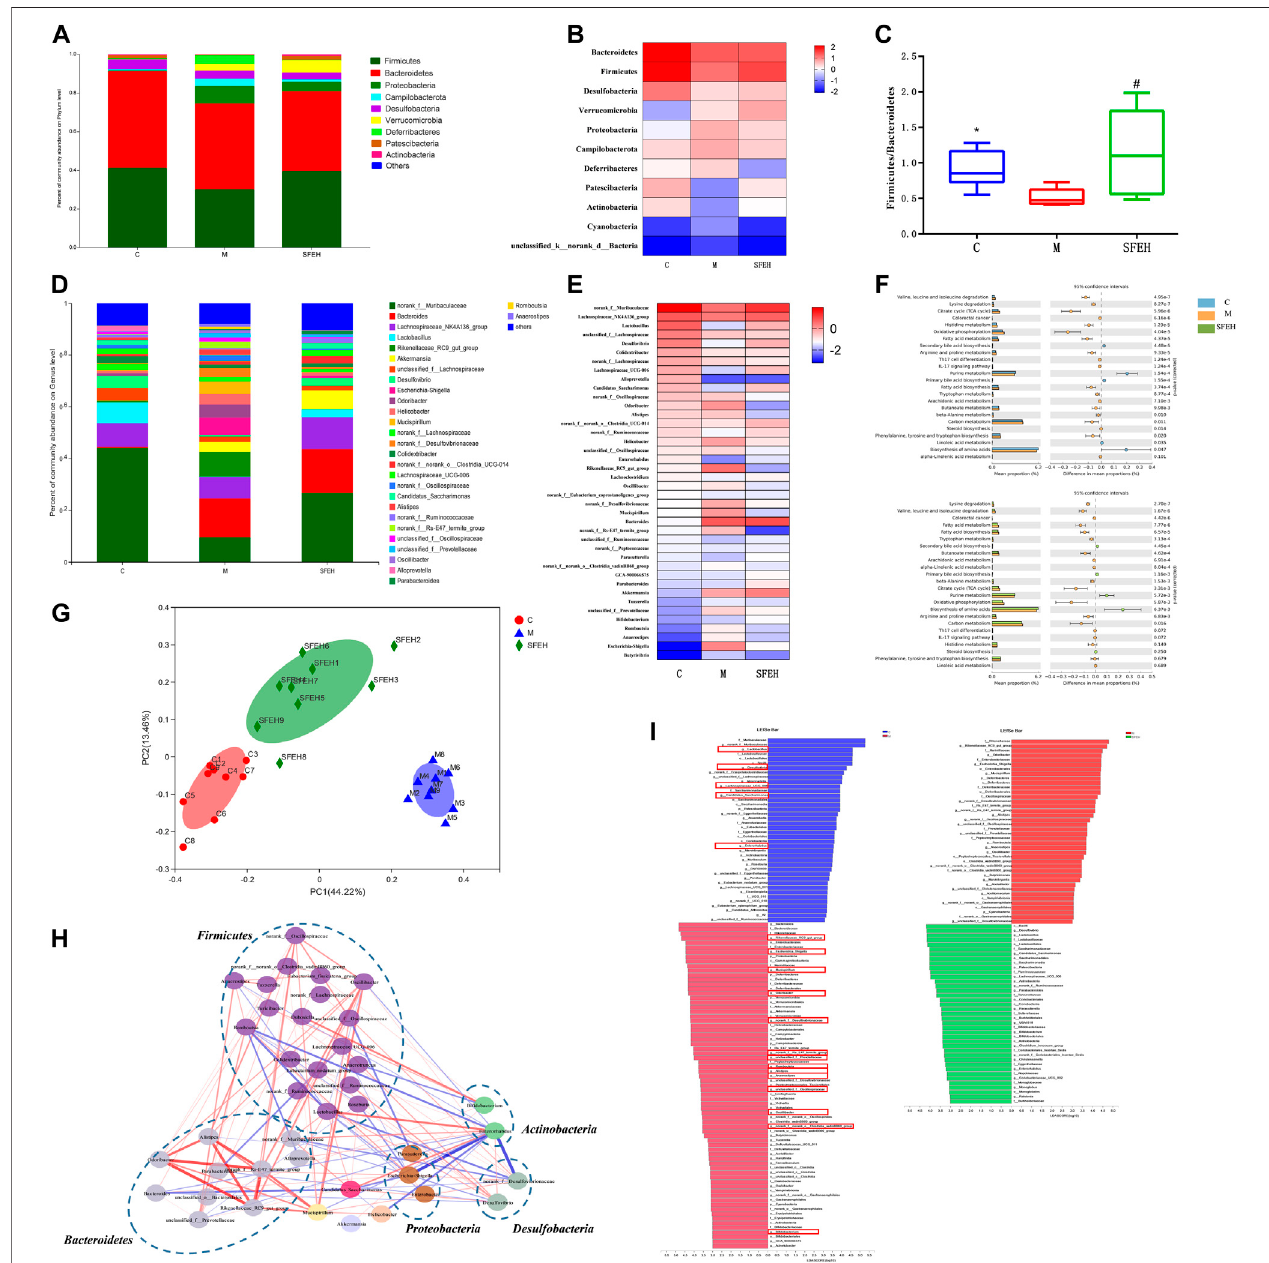
FIGURE 3 | SFE alleviated DSS-induced gut dysbiosis. (A,D) The community bar of the control, model, and SFE-H groups at the phylum and genus levels. (B,E) ThecommunityHeatMapofthecontrol,modelandSFE-Hgroupatthephylumandgenuslevels; (C) Firmicutes / Bacteroidetes valueofeachgroup; (F) PICRUStanalysis between the control and model groups, and between the model and SFE-H groups. (G) The PCoA model of the control, model, and SFE-H groups based on the Bray – Curtisalgorithm. (H) Theinteractionnetworkofthespeci fi cbacteria(thestrengthoftheinteractionisrepresentedbythethicknessanddepthofthelines.The strongertheinteraction,thethickeranddarkeralineis.Theredlinerepresentsthepositiverelationship,andthebluelinerepresentsthenegativerelationship). (I) TheLDA scores of discriminative taxa in the control and model groups, and in the SFE-H and model groups. * means that the control group compared with the model group is signi fi cant;#means thatthemodel groupcompared withtheadministrated group issigni fi cant;*, #means p < 0.05;C, M,and SFE-Hrepresentthecontrol,model, and SFE-H groups, respectively.